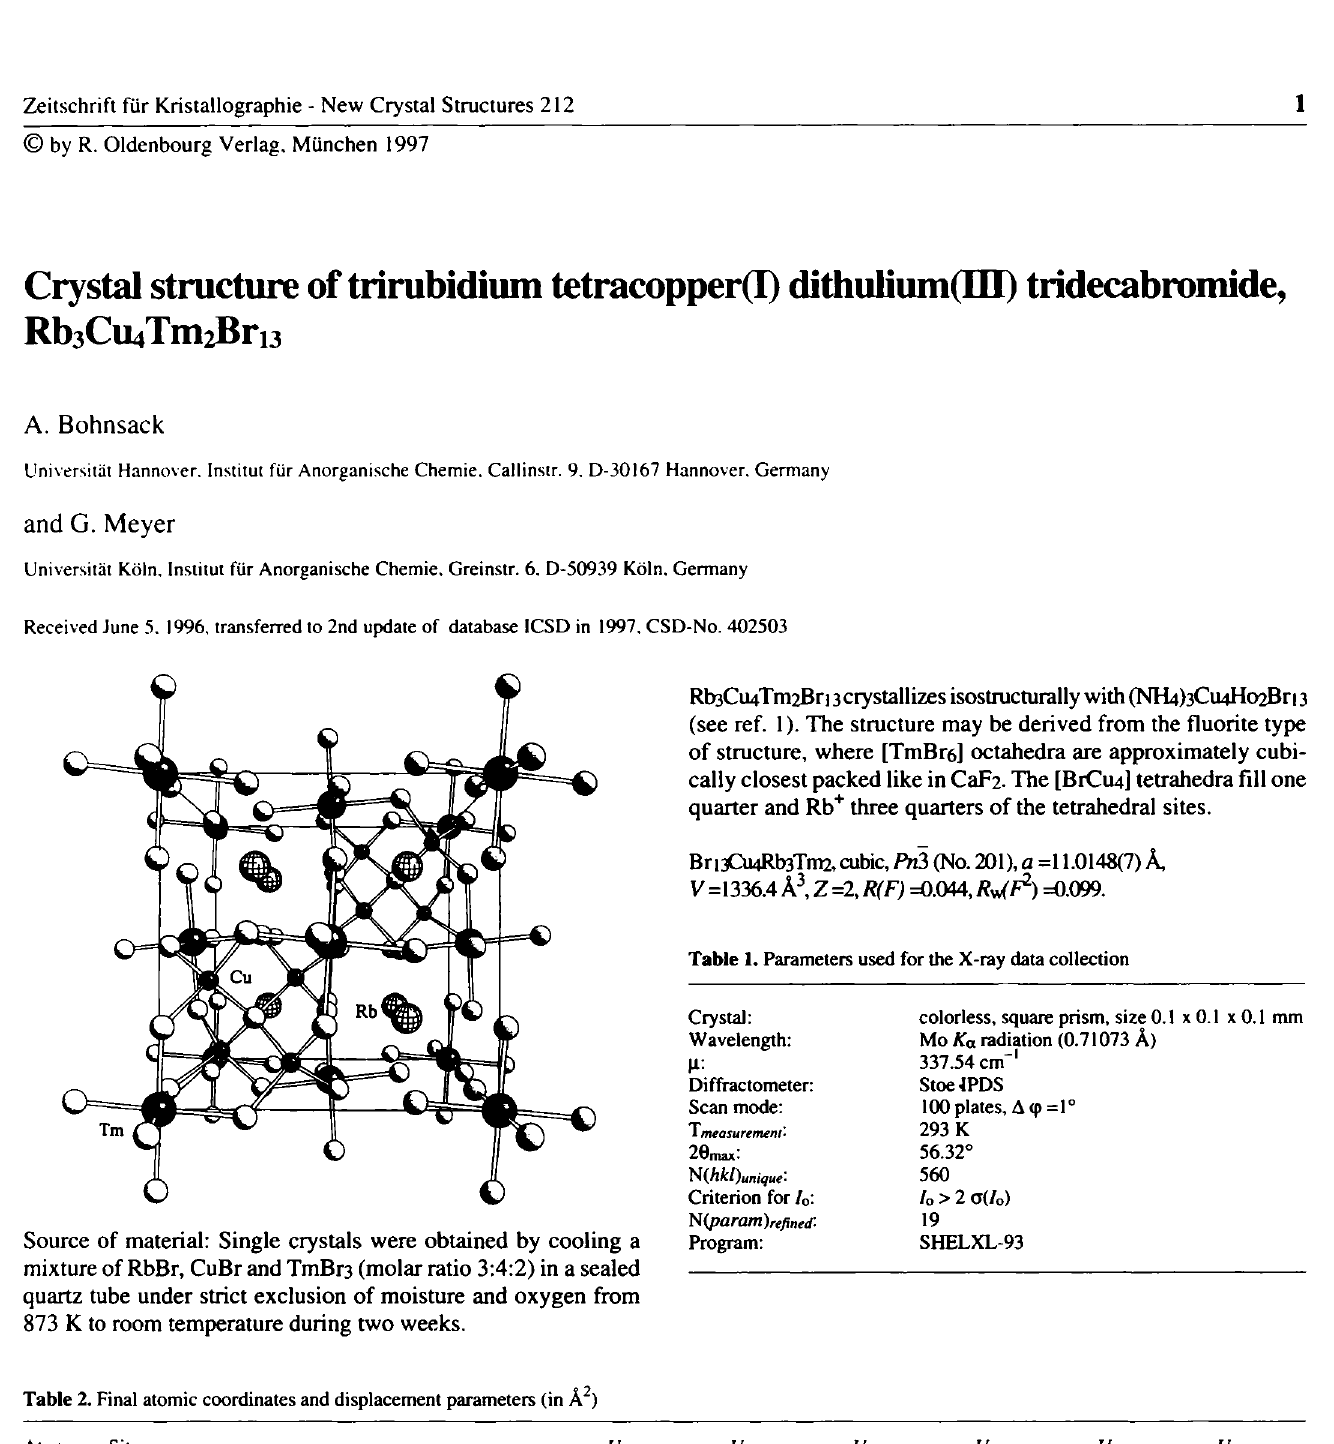
Table 2. Final atomic coordinates and displacement parameters (in Â 2 ) Atom